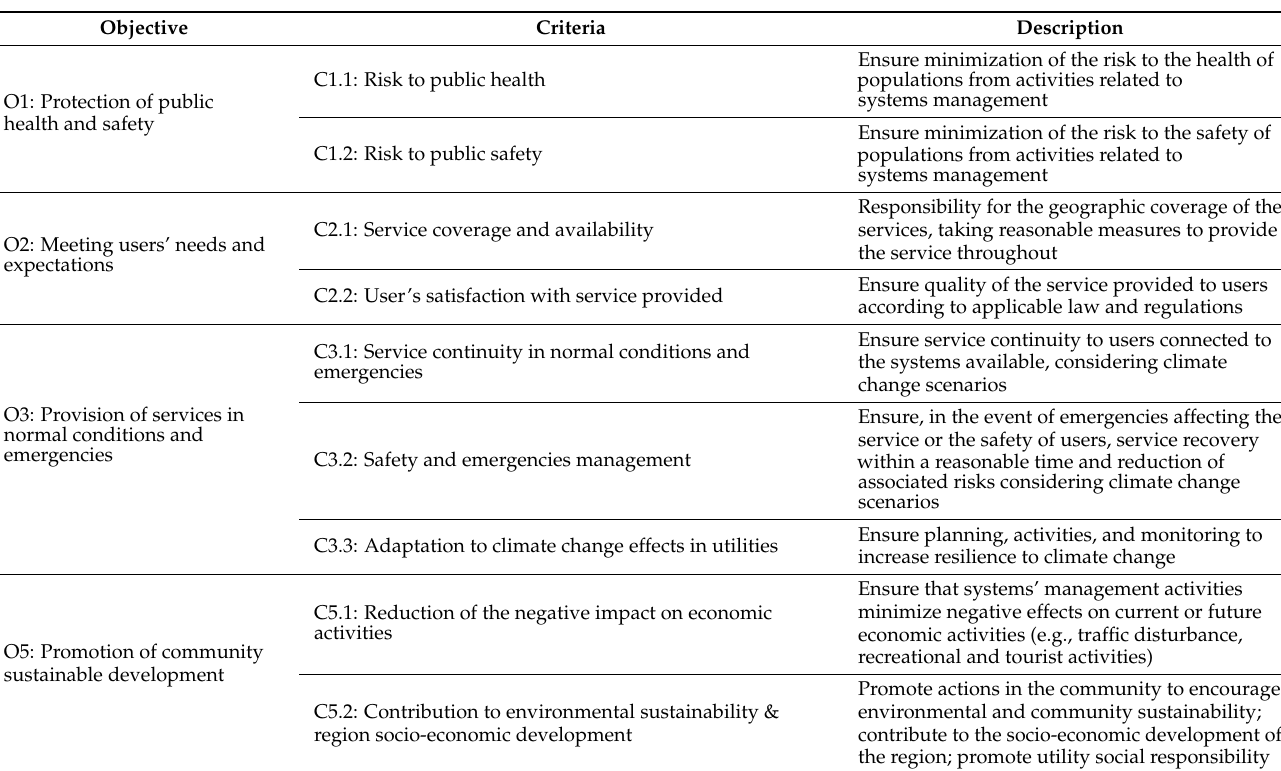
Table 4. Strategic assessment